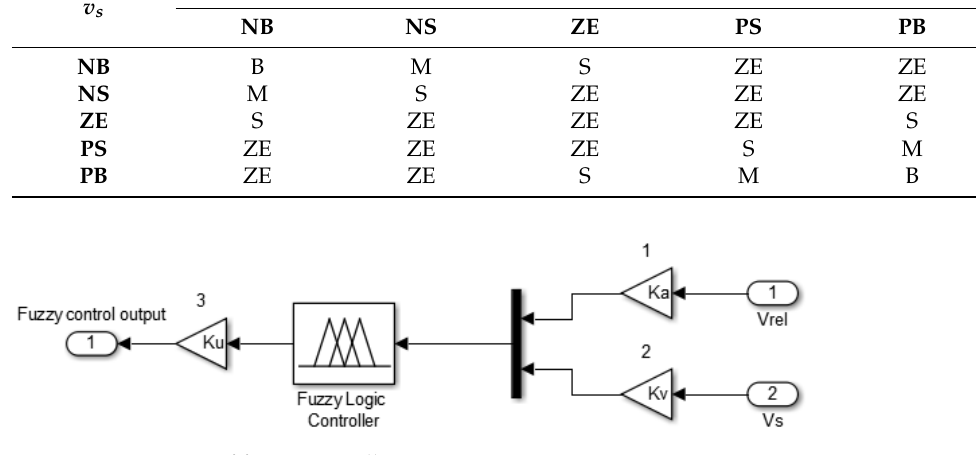
Figure 22. Structure of fuzzy controller. Table 3. Fuzzy control rule table.